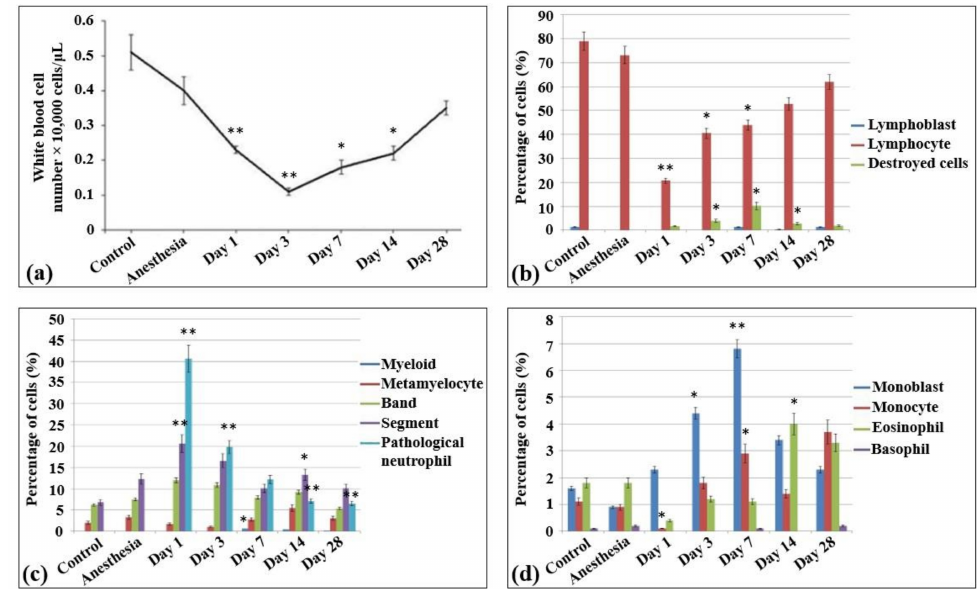
Figure 1. Cellularity and composition of white blood cells in the blood of control rats and after the irradiation with the laser-driven UPEB. ( a ) Total amount of white blood cells in peripheral blood of rats ( µ L). Percentages of ( b ) lymphoid and destroyed cells; ( c ) myelocytes and immature, mature, and pathological neutrophils; and ( d ) monoblasts, monocytes, eosinophils, and basophils. The number of rats in each group, n = 6. * p < 0.05; ** p < 0.001 (compared to